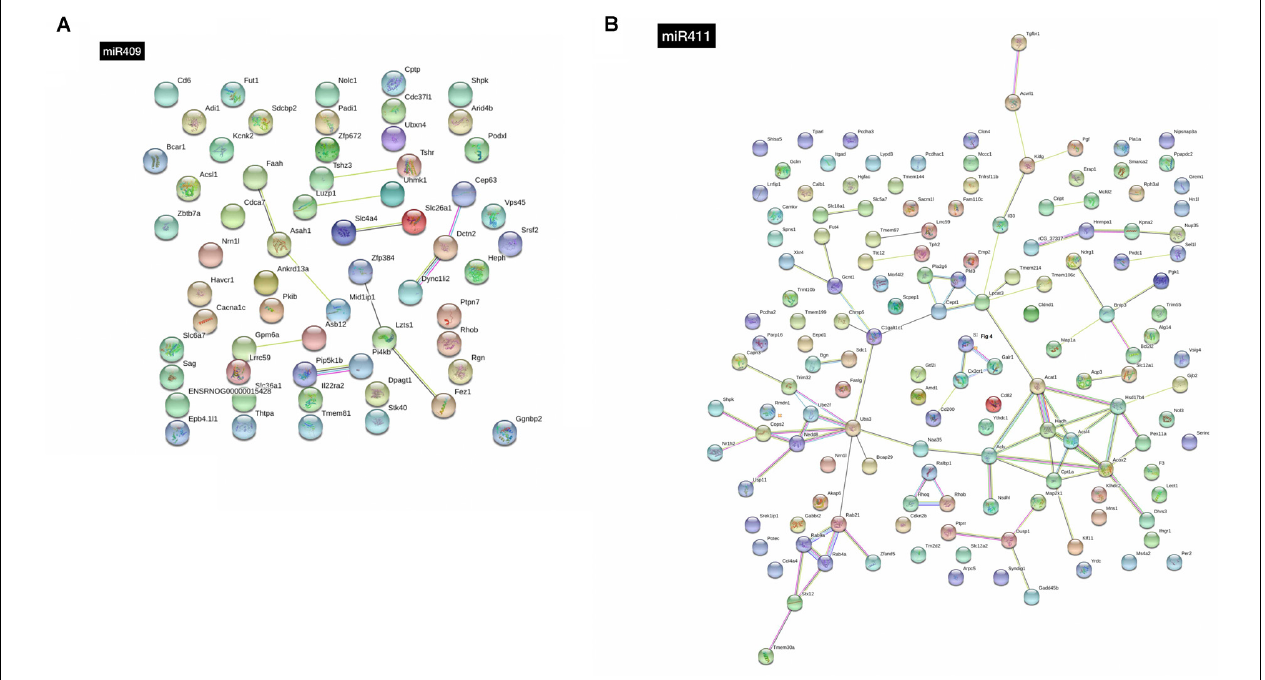
FIGURE 3 | STRING analysis of the interactions between the target genes of (A) miR-409-5p and (B) miR-411-5p. Thicker lines indicate stronger network connections between the